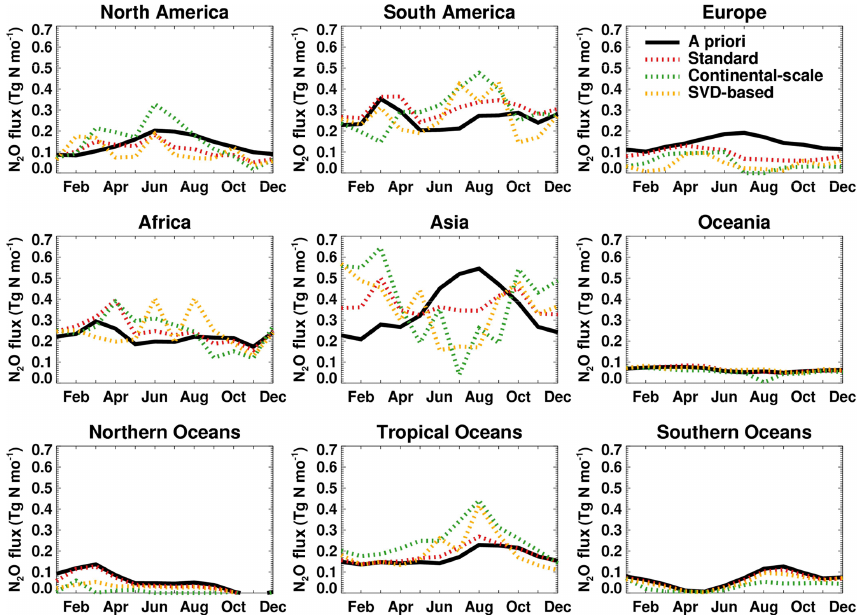
Figure 7. Monthly N 2 O emissions for 2011 over six continental and three oceanic regions. Shown is the a priori database (black) and a posteriori results for the standard 4D-Var inversion (red), the continental-scale inversion (green), and the SVD-based inversion